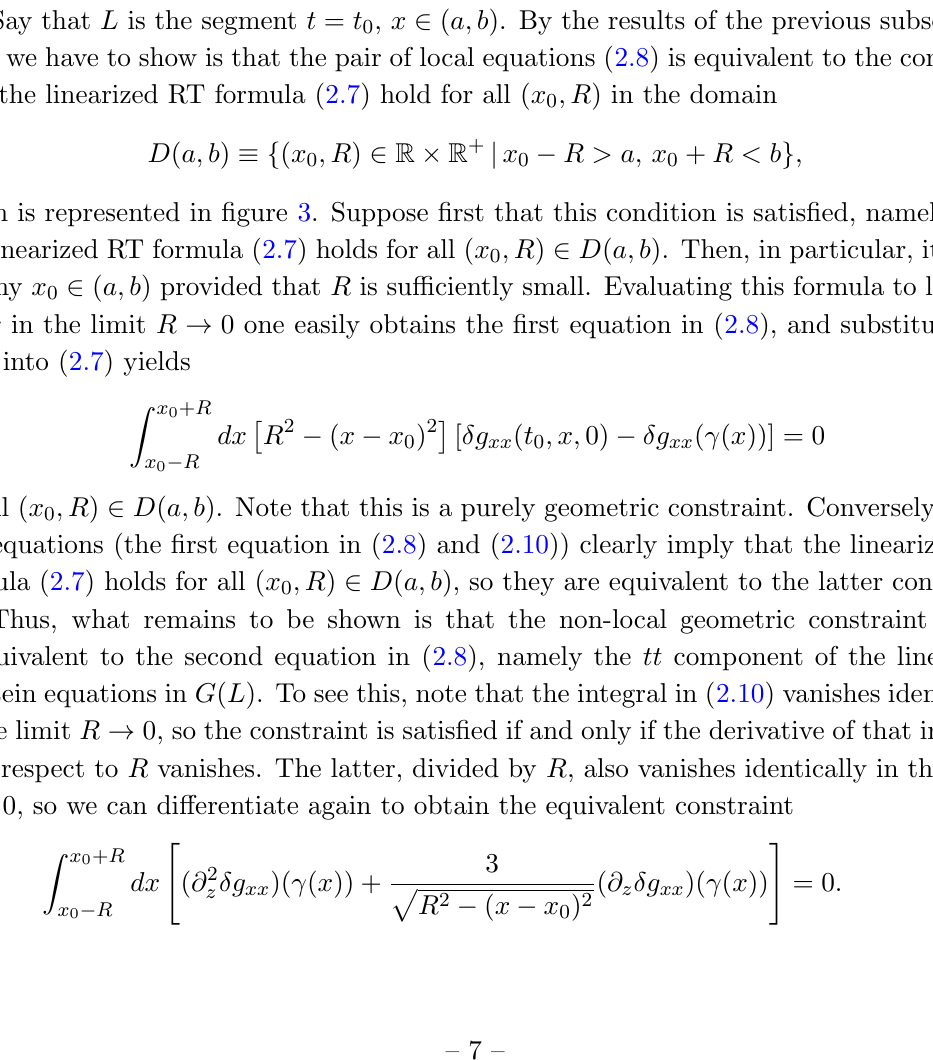
Figure 2 . The union G ( L ) of all AdS geodesics with both endpoints inside a boundary segment L at constant time t 0 . The red semicircle is the geodesic joining the endpoints of L . where G ( L ) denotes the union of all AdS geodesics with both endpoints in L . Note that, in the coordinates we are using, this is a semidisk at constant time, as shown in (cid:12)gure 2. The second equation above is the tt component of the linearized Einstein